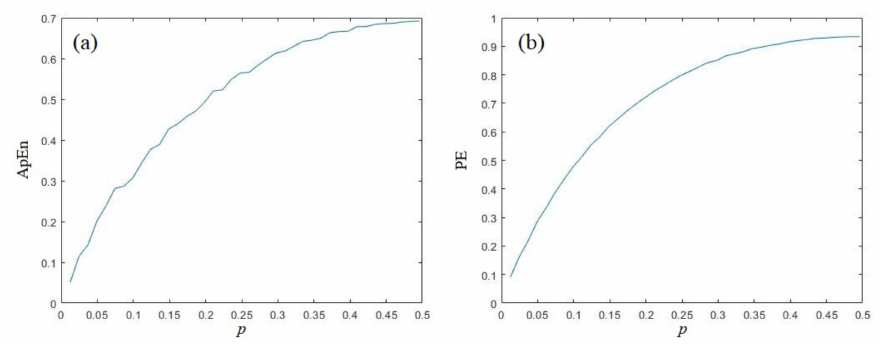
Figure 2. Complexity analysis of Baker sequence; ( a ) ApEn; ( b )